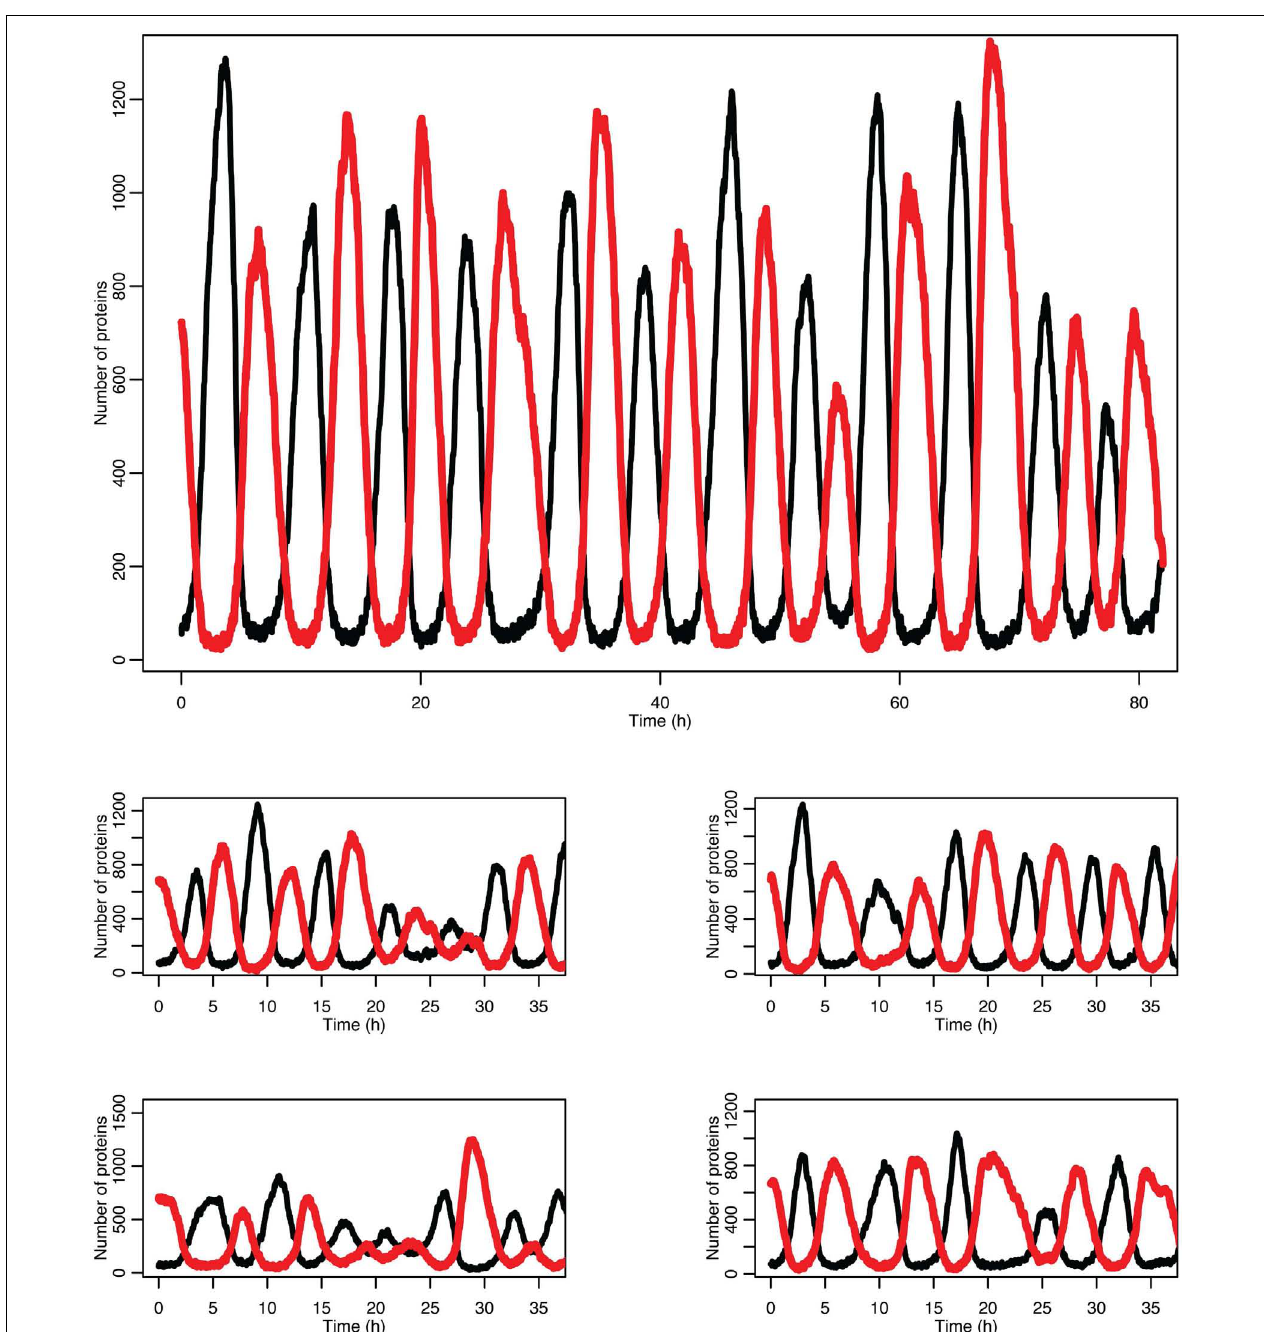
FIGURE 5 | Examples of time courses in the stochastic model. p53 is in black and MDM2 is in red.